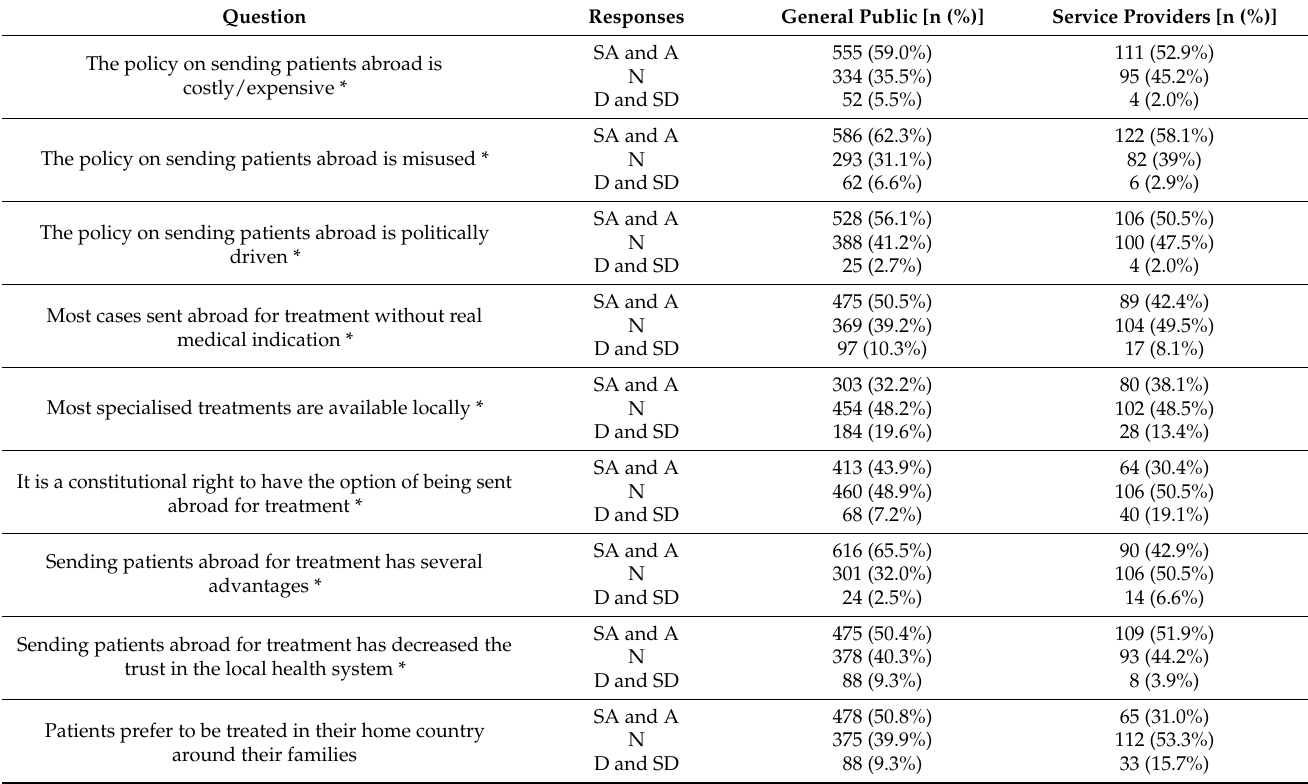
Table 10. Respondents’ opinions on the policy on sending patients abroad for